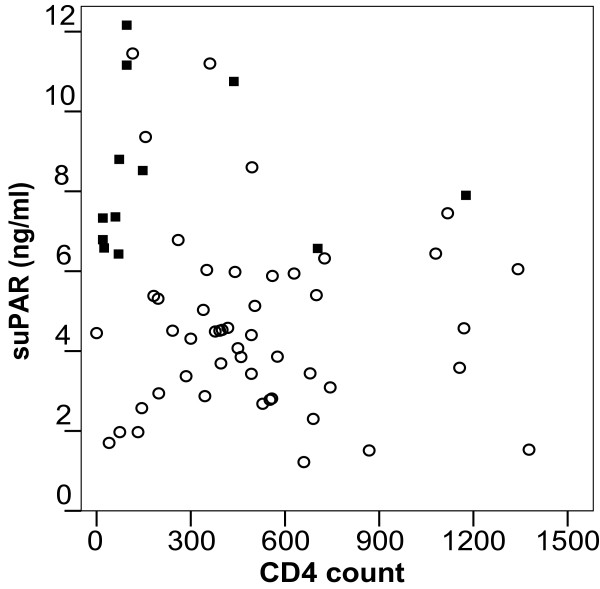
Scatterplot of CD4 T cell counts and suPAR. No significant correlation was observed (Pearson r = -0.22, p = 0.09). Patients that died (N = 13) within 2 years of blood sampling are shown as black squares.